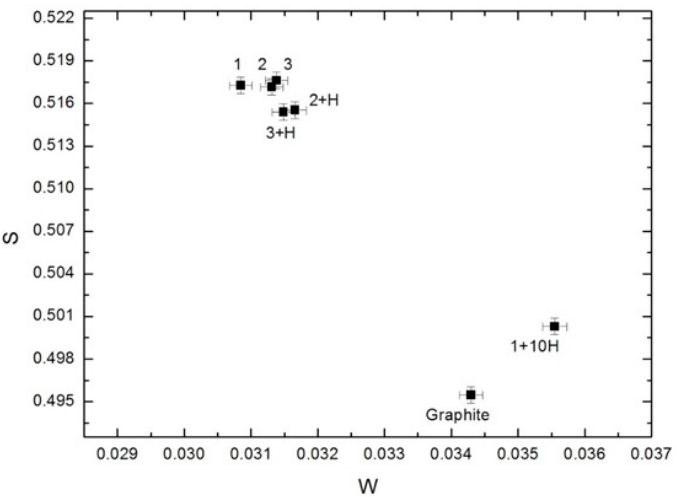
Figure 11. Dependence of the S -parameter on the W -parameter for non-hydrogenated and hydrogenated nanodiamond samples.